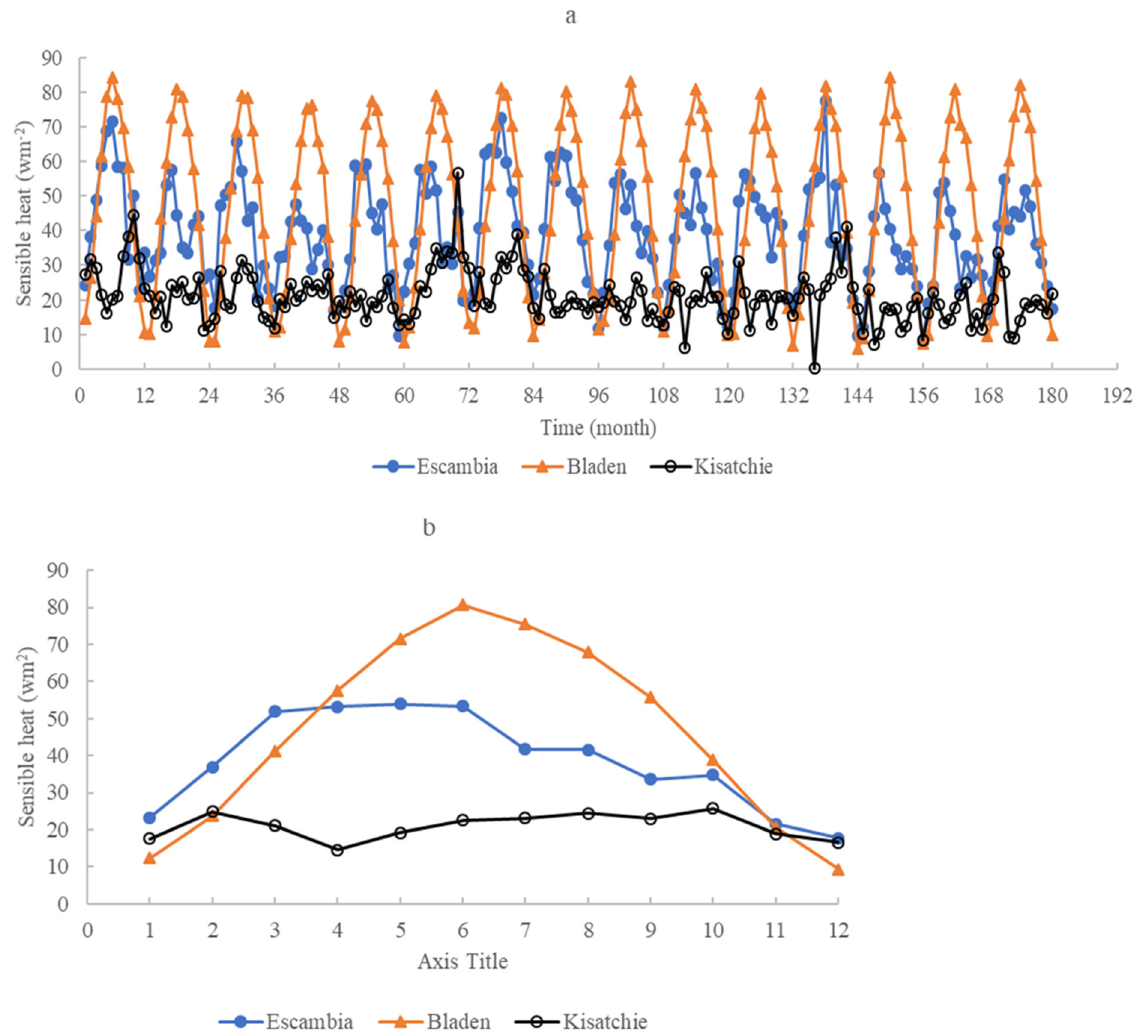
Figure 10. Dynamics of sensible heat net flux in Escambia, Bladen, and Kisatchie. ( a ) The monthly and yearly sensible heat net flux from January 2000. ( b ) The integrated monthly average of sensible heat net flux.